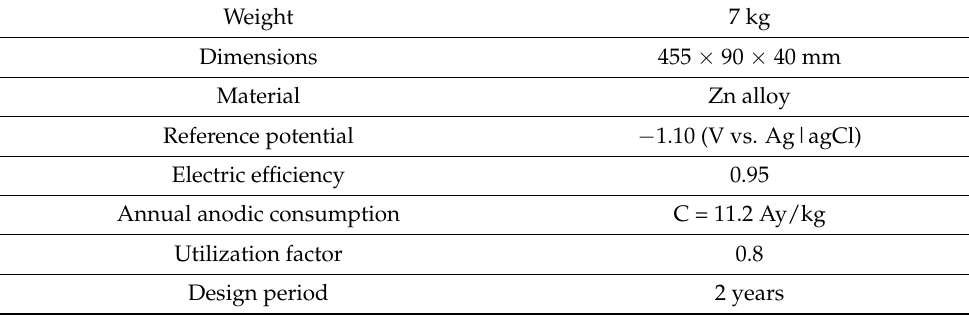
Table 3. Characteristics of the anode used for the case